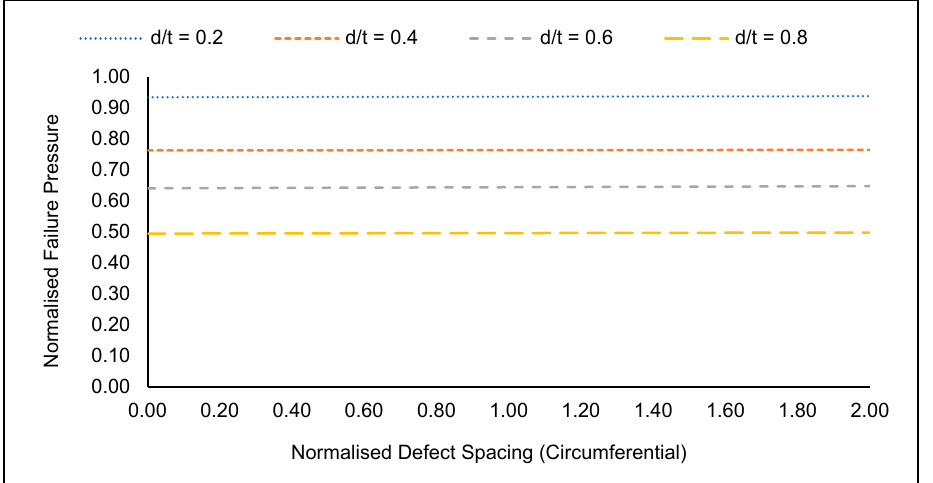
Figure 12. Normalised failure pressures of corroded (defect at the intrados) API 5L X80 pipe elbow with a normalised defect spacing (circumferential) of 0.5 subjected to a normalised axial compressive stress of 0.2.